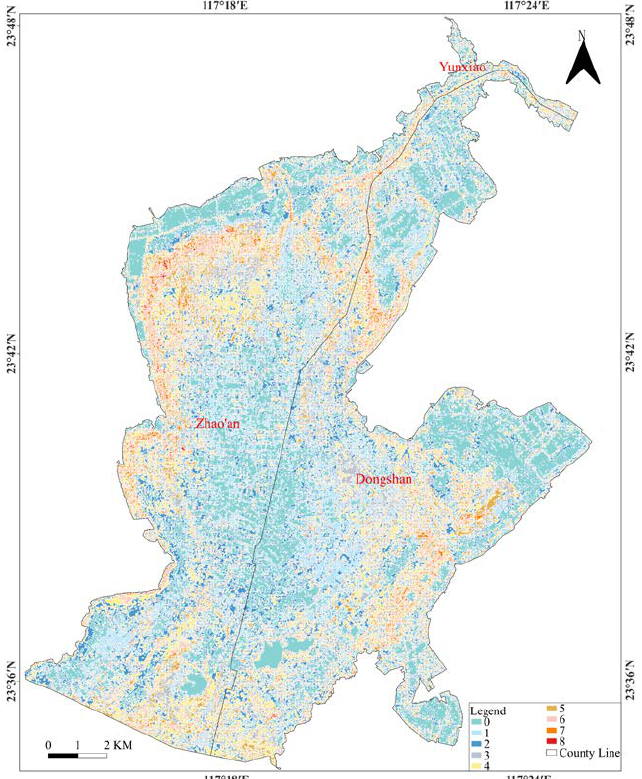
Figure A7. Pixel-scale change frequency of different mariculture types from 2013 to